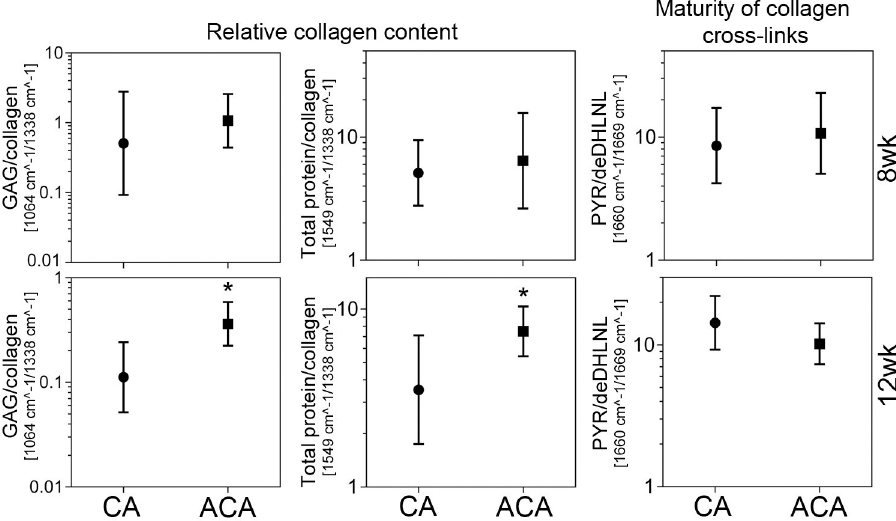
Fig 6. A graphic representation of the FTIR-based assays of the relative amount of collagen and the maturity of collagen cross-links in the scar tissue formed within injured posterior capsules of control (CA) and the ACA- treated rabbits. Results for the 8wk and the 12wk groups are presented. The graphs show geometric means (GMs) with 95% confidence intervals. Asterisks indicate groups with statistically significant differences of the means. The graph shows the relative collagen content calculated as the sulfated glycosaminoglycans (GAGs)/collagen and the total protein/collagen ratios. Consequently, the smaller the ratios, the higher relative collagen content. The ratios were calculated based on the areas of the spectral peak corresponding to the sulphated GAGs (centered around 1064 cm -1 ) and the spectral peak corresponding to collagen (centered around 1338 cm -1 ). To corroborate these measurements, the relative amount of collagen was also calculated based on the ratios of the spectral peak corresponding to the total proteins, represented by the amide II peak (centered around 1549 cm -1 ) and the spectral peak corresponding to collagen. The maturity of collagen cross-links was expressed as the ratio of the area of the spectral peak corresponding to the mature trivalent PYR cross-link (centered around 1660 cm -1 ) and immature divalent deDHLNL cross-link (centered around 1690 cm -1 ). Hence, the higher the PYR/deDHLNL ratio the more mature collagen cross-links. Also, see S1 Table in S1 File.